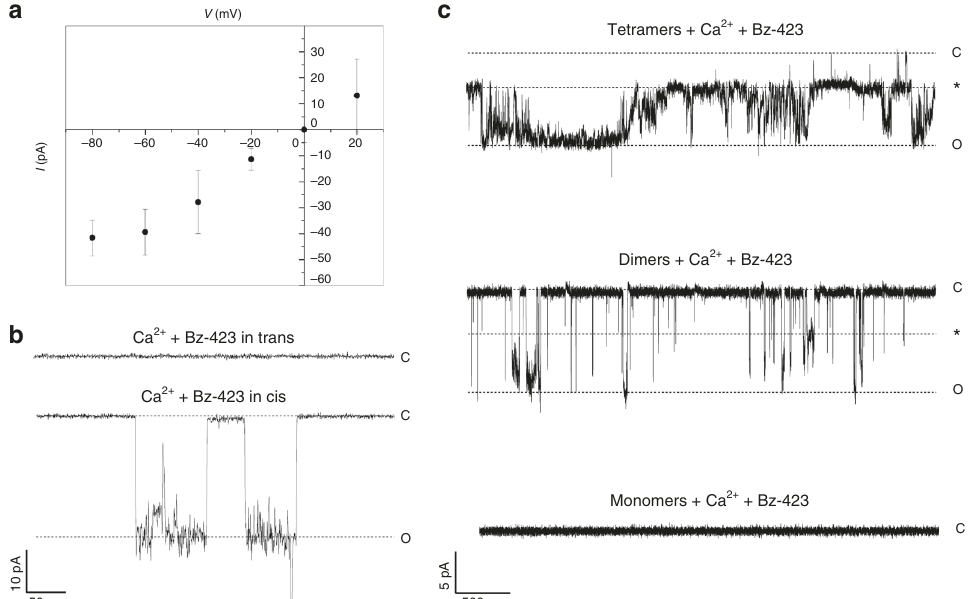
Fig. 4 Characterization of channel activity of bovine F-ATP synthase. a Currents were recorded at the indicated voltages ( n = 7, error bars refer to SEM). b F-ATP synthase was added to the cis side of the recording cuvette. No channel activity was detected when Ca 2 + up to 3 mM and 0.15 mM Bz-423 were added to the trans side, while channel activity appeared when the same concentrations of Ca 2 + and Bz-423 were subsequently added to the cis side ( V cis = – 60 mV, G = 500 pS for prevalent conductance state indicated with O). The two traces shown are from one representative experiment of four. c Electrophysiological assessment of gel-eluted bovine F-ATP synthase. Monomers, dimers, and tetramers of F-ATP synthase were eluted from BN-PAGE gels and reconstituted into planar lipid bilayers. Channel activity was assessed in the presence of Ca 2 + up to 3 mM and 0.15 mM Bz-423 added to the cis side. Both dimers ( n = 8) and tetramers ( n = 9) elicited channel activity while monomers elicited no activity ( n = 7). Representative traces are shown at V = – 60 mV. The closed state is denoted with C, the most frequent subconductance state with an asterisk, and the maximal open state with O. The cis source data underlying panel a are provided as a Source Data fi